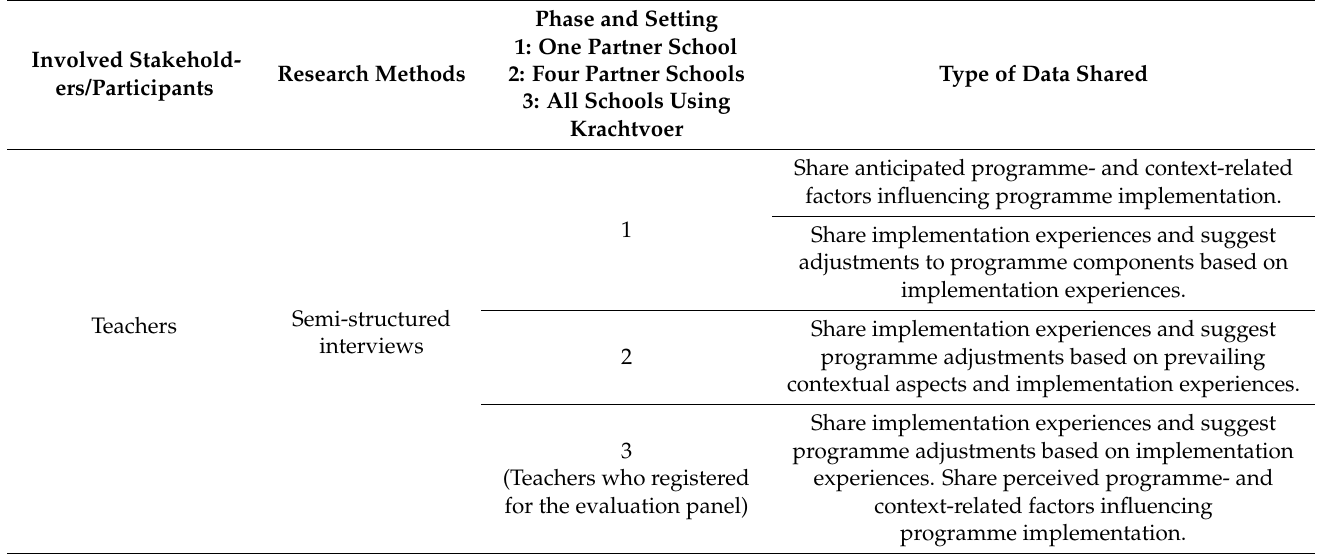
Table 1. Overview of action-oriented research methods and type of data shared in the three programme development phases.